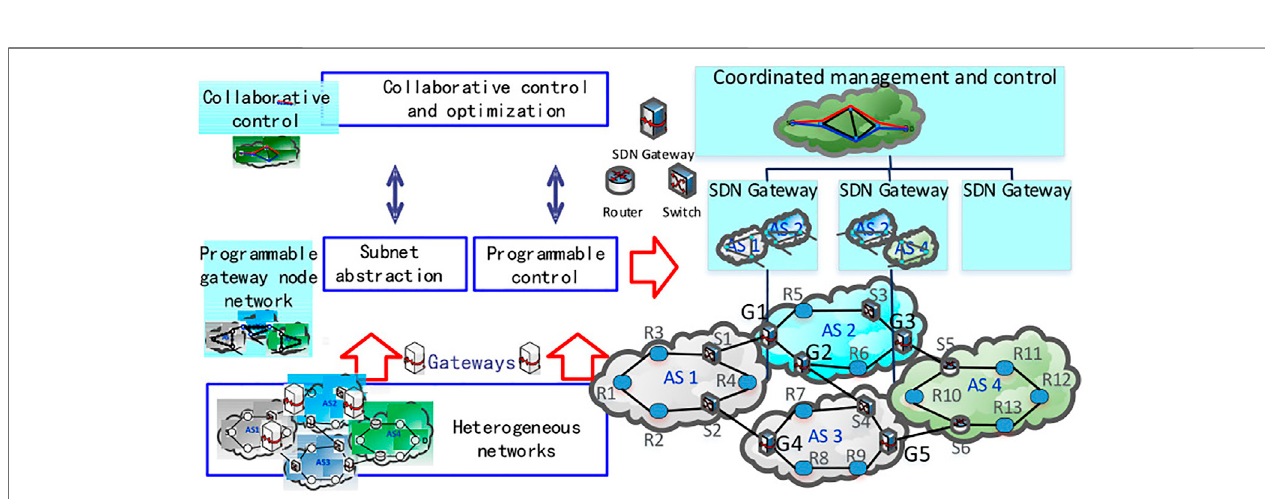
FIGURE 4 | The SD-SGN architecture interconnects and integrates of heterogeneous networks.